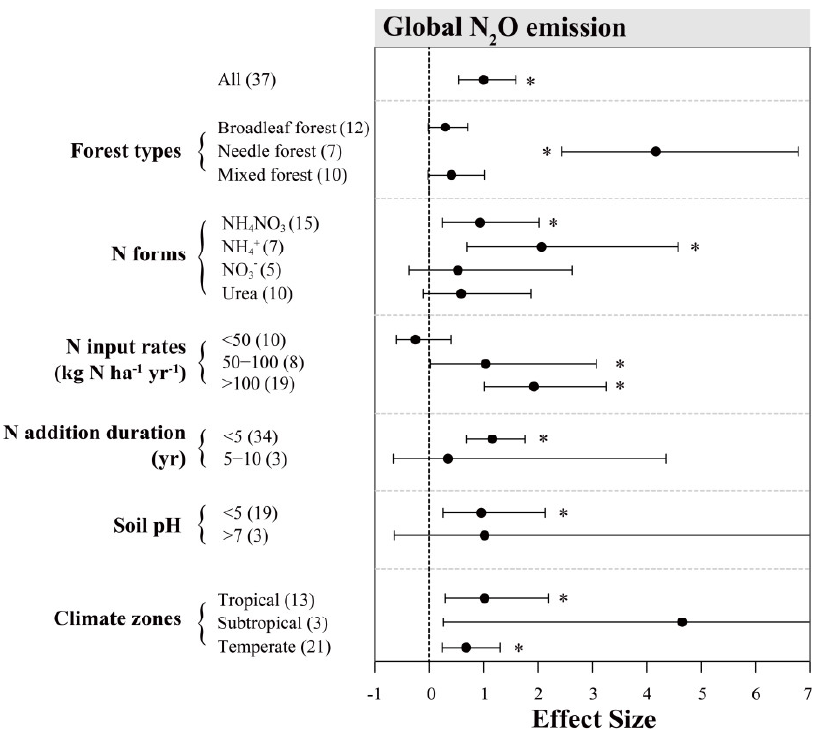
Figure A1. Effects of N inputs on forest soil N 2 O emissions outside China. Error bars represent 95% confidence intervals (CI). The vertical dashed line indicates effect size = 0. If the 95% CI does not overlap with zero, the effect of N input is considered as statistically significant and denoted by * in the figure. From top to bottom are the results of subgroups, including “forest types, N forms, N input rates (kg N ha − 1 yr − 1 ), N addition duration (yr), soil pH and climatic zones”. Numbers in parentheses represent the sample